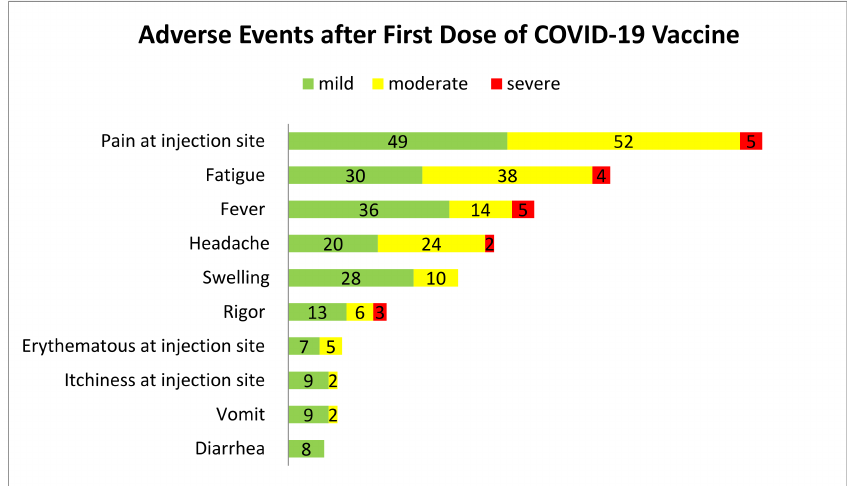
Figure 1. Adverse events after first and second dose of COVID-19